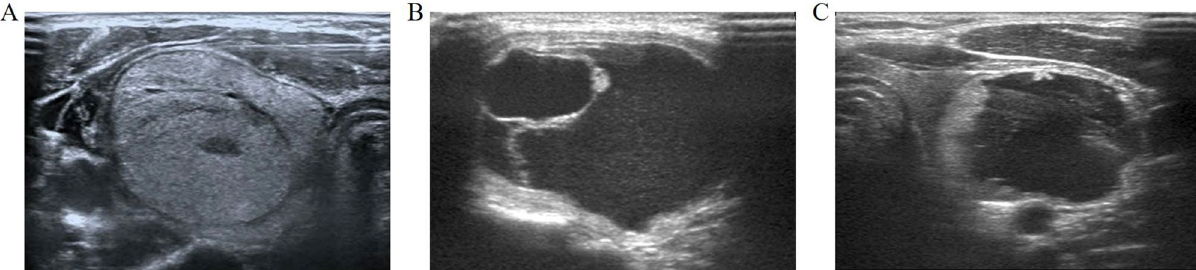
Figure 1. Different types of benign thyroid nodules (BTNs). ( A ) US image of a solid thyroid nodule. ( B ) US image of a cystic thyroid nodule. ( C ) US image of a colloid thyroid